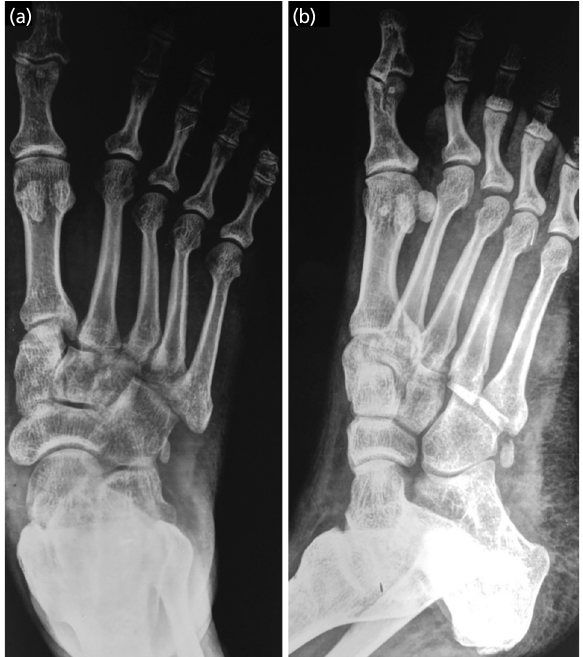
Fig. 1: Radiograph of foot showing dislocation of 3rd MTP joint. Fig. 2: (a) Anteroposterior and (b) oblique radiographs of foot